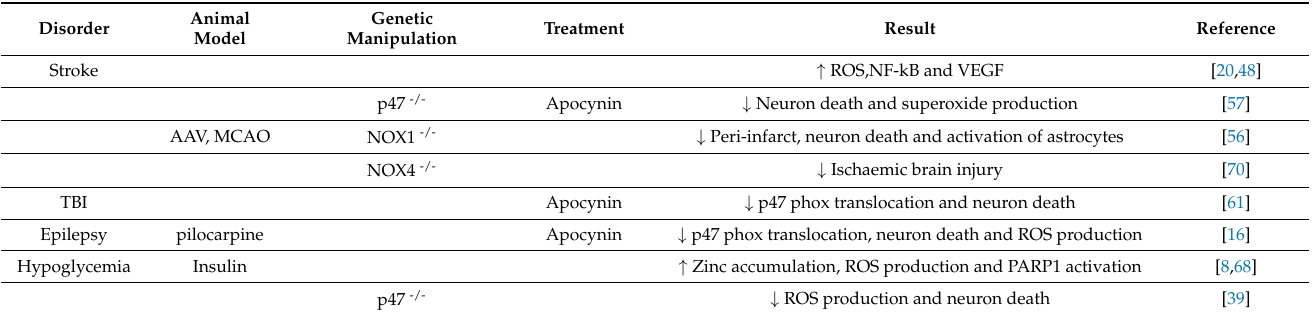
Table 1. NOX deletion and NOX inhibition effects in animal models. An overview of published studies utilizing rodents. Disorder Animal